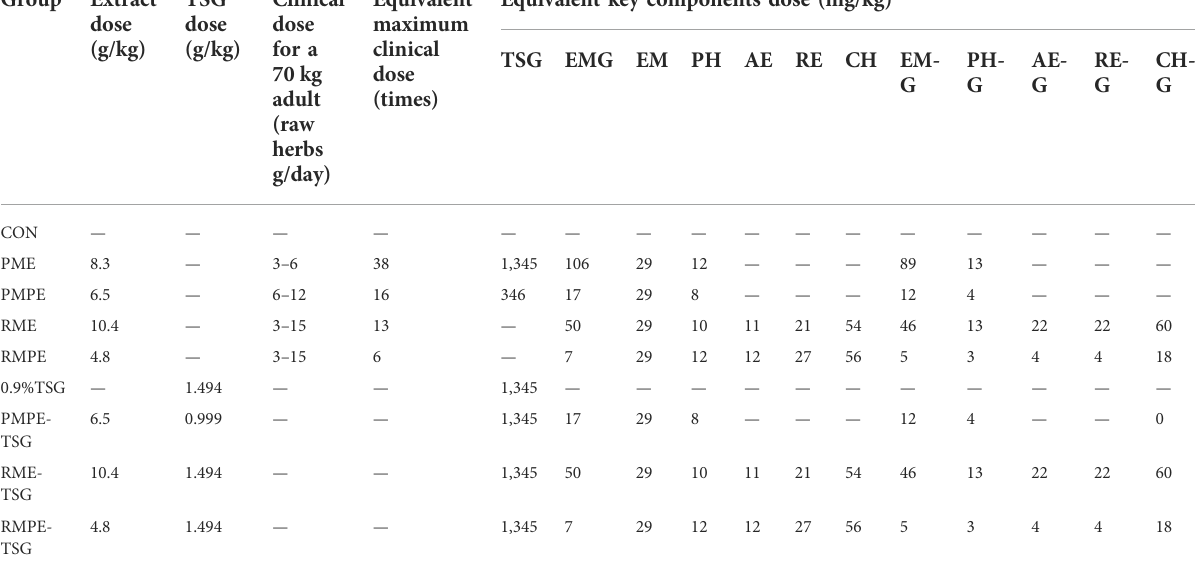
TABLE 2 Experimental groups and dosing regimen for PM hepatotoxicity study in ICR mice. Group Extract dose